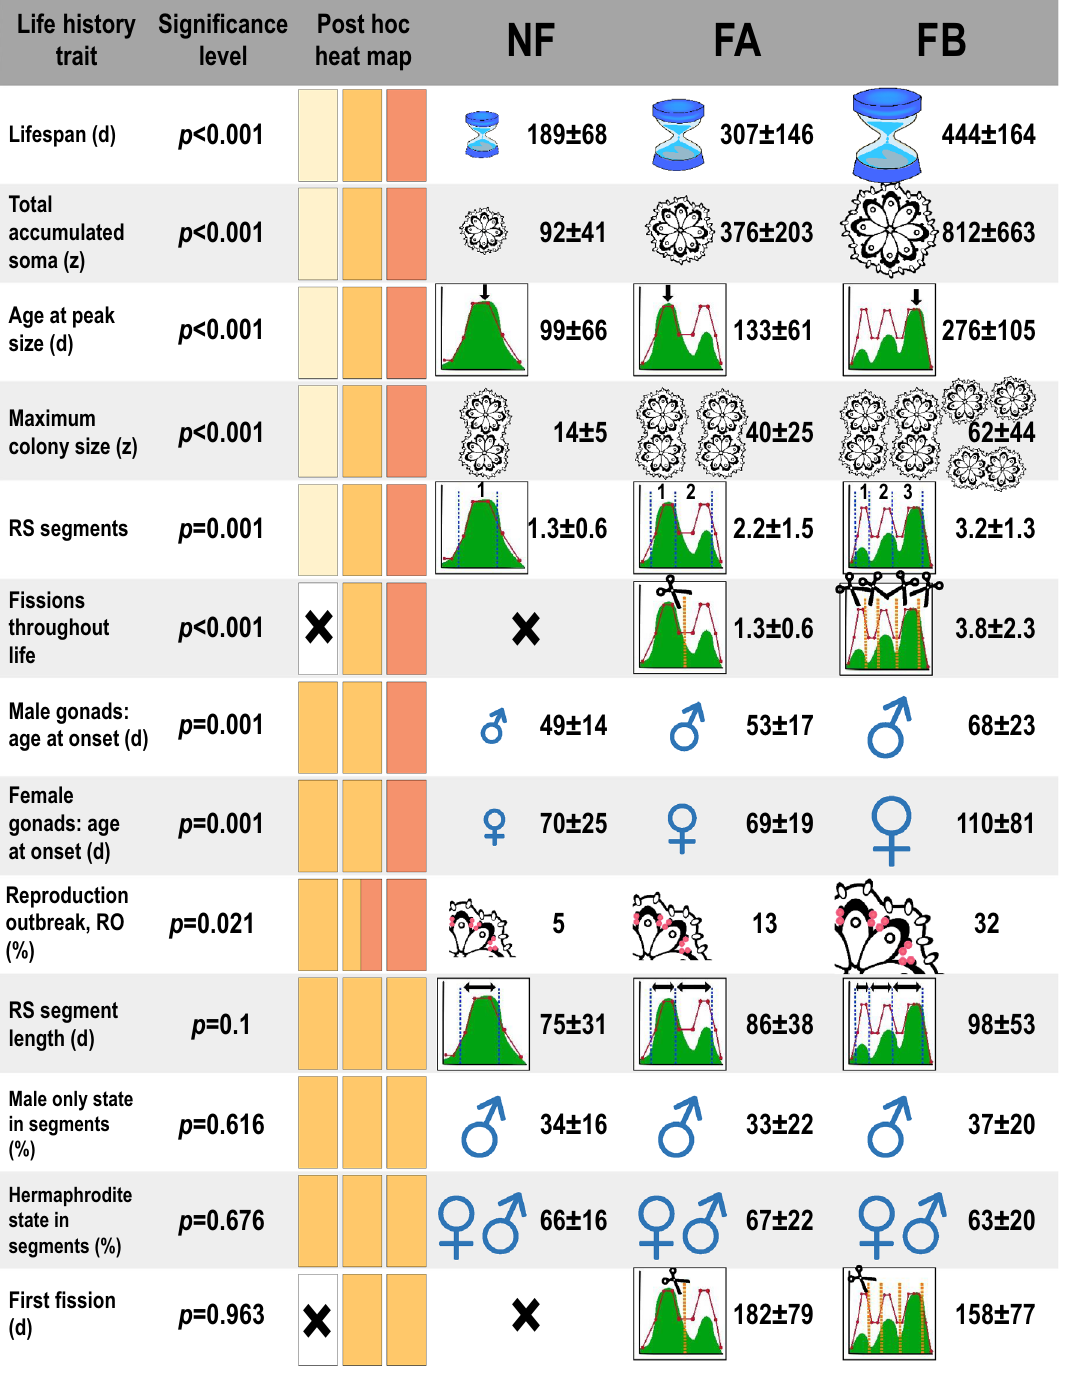
Figure 4. The major traits’ epitomes that describe the three life histories (NF, FA and FB) as expressed by B. schlosseri colonies maintained under relaxed environmental settings. Traits are organized according to p values, from those portraying three statistically significant groups to traits that do not differ between the life histories. Significant post-hoc test results are visualized by the heat map (from left to right: NF, FA, FB) where different colors indicate significantly different groups. Where possible, self-explanatory graphical icons depict the major outcomes, with size differences revealing the statistical differences. d = days; z = zooids; RS = Reproductive statuses; RO = Reproduction outbreak; NF = colonies that did not fission throughout their lives; FA = colonies that fissioned after reaching peak numbers of zooids; FB = colonies that fissioned before reaching peak numbers of